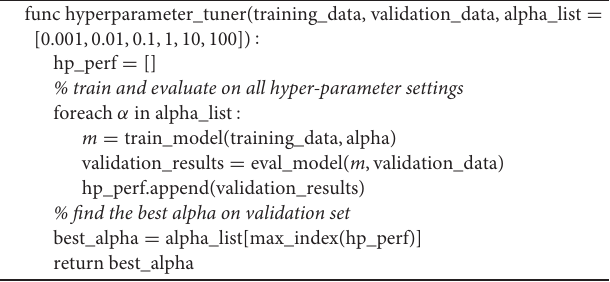
Algorithm 1: The pseudo code for searching for the best α value in